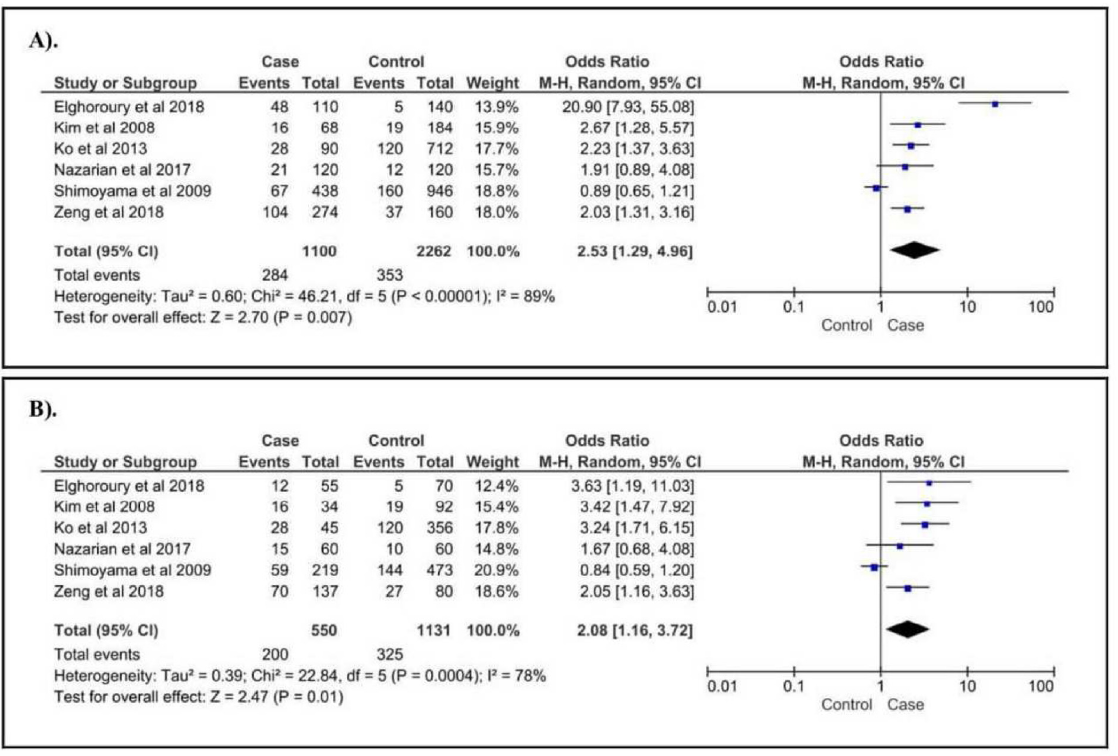
Figure 4. Forest plot of the association between KL G395A gene polymorphism and the risk of CKD. ( A ). A vs. G of KL G-395A; ( B ). GA vs. GG+AA of KL G395A.